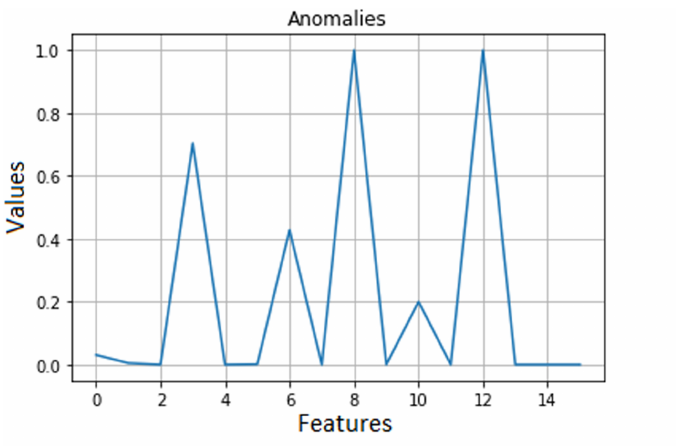
Figure 5. Values for one abnormal data record from the training